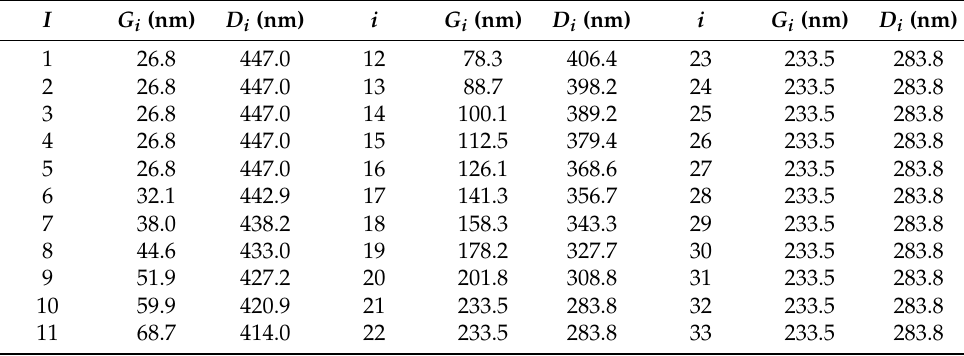
Table 2. Specific values of G i and D i for each grating period ( Λ i = G i + D i